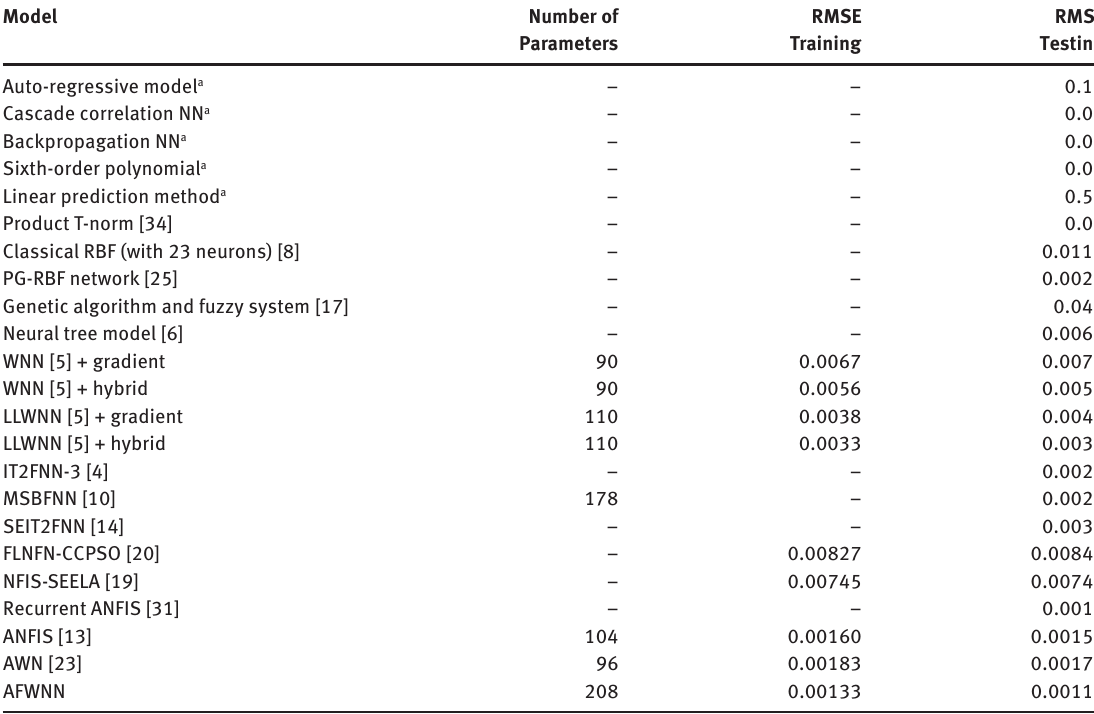
Table 3. Comparison of the Training and the Testing Performance of Different Models for Mackey Glass Time